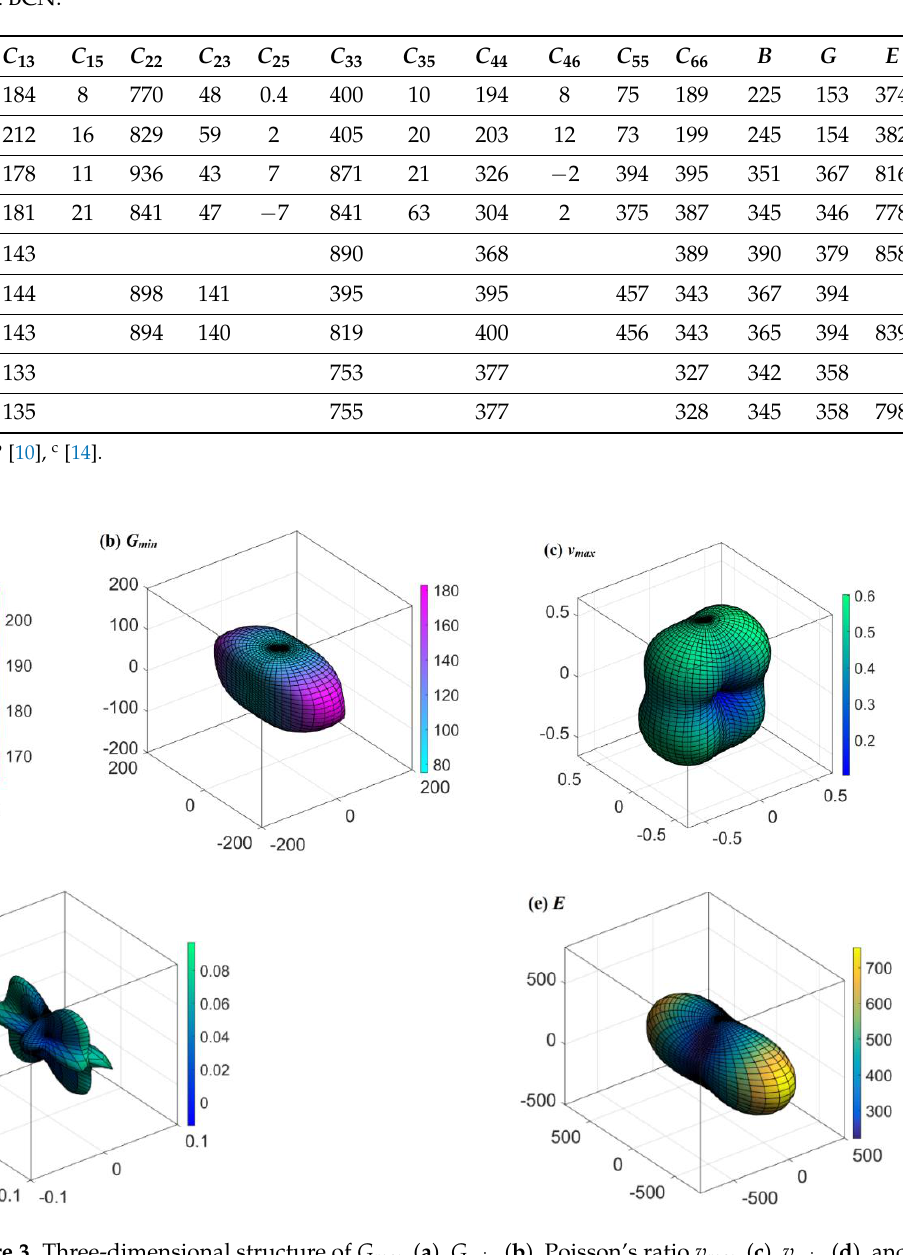
Figure 3. Three-dimensional structure of G max ( a ), G min ( b ), Poisson’s ratio v max ( c ), v min ( d ), and E ( e ) of Pm -BCN.